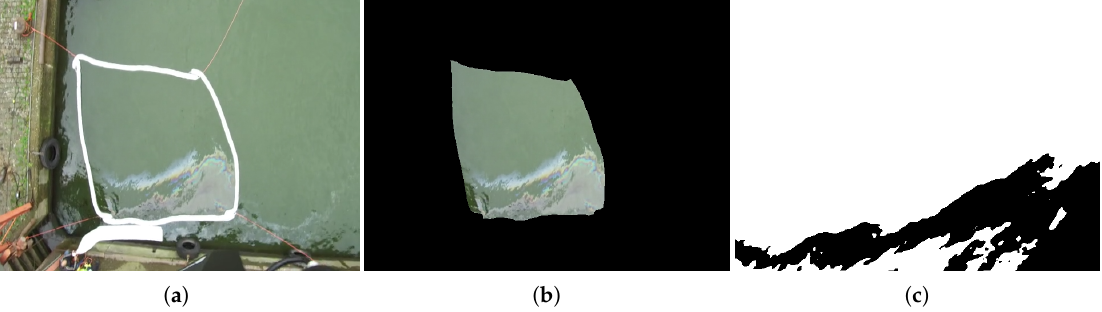
Figure 7. RGB Pipeline ( a ) Original RGB image. ( b ) RGB image with center extracted ( c ) Final mask, white color represents water, black represents oil.